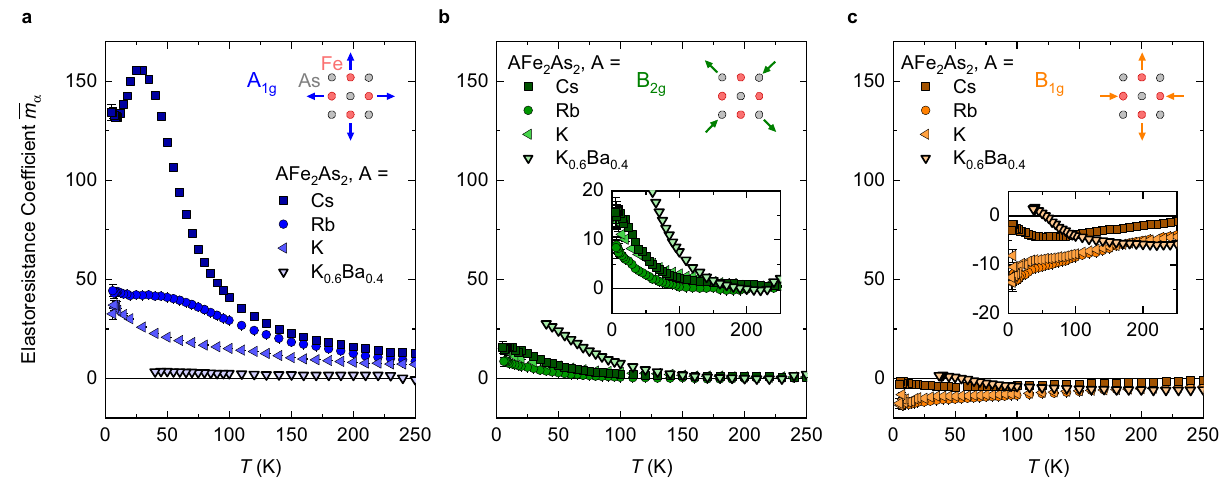
calculated from ϵ xx ∥ [110] data. b (cid:1) m B . c 1 g 2 g